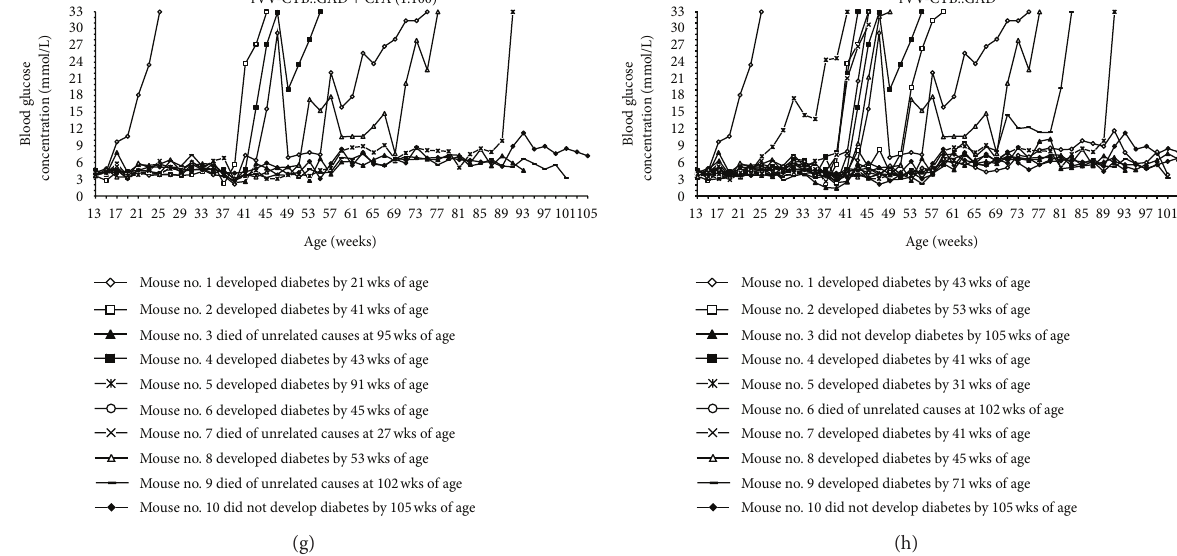
Figure 2: Blood glucose levels in individual animals of all experimental groups. (a) Mock-infected experimental group of 5-week-old NOD mice ( 𝑛 = 10 ) was inoculated with PBS. (b), (c), and (d) Three experimental groups of mice ( 𝑛 = 10 ) were subjected to s.c. injection with 0.1mL of undiluted (1: 0) and 1:10 and 1:100 diluted CFA. (e), (f), and (g) Groups of mice rVV-CTB::GAD + CFA (1:0), and rVV-CTB::GAD + CFA (1: 10), rVV-CTB::GAD + CFA (1:100) ( 𝑛 = 10 ) were injected with the 0.3mL virus (5 × 10 7 PFU/mL) i.p. and s.c. coinoculated with 0.1mL CFA. (h) The rVV-CTB::GAD group of mice ( 𝑛 = 10 ) was subjected to i.p. injection with 0.3mL of the virus (5 × 10 7 PFU/mL). Two weeks after the first injection, the vaccine inoculations were repeated. Beginning at 13wks of age the individual mice in each experimental group were bled from the tail vein biweekly for 119wks, and blood sugar levels were quantified.